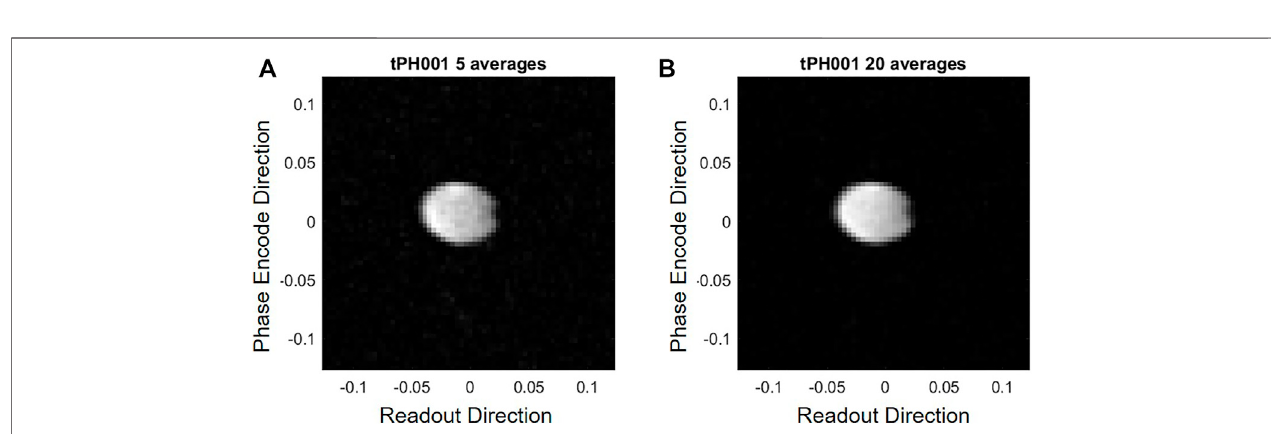
FIGURE 7 | Comparison between 5 averages (SNR = 23) (A) and an 20 averages (SNR = 39) (B) for a turbo spin echo sequence of image the cylindrical water phantom.